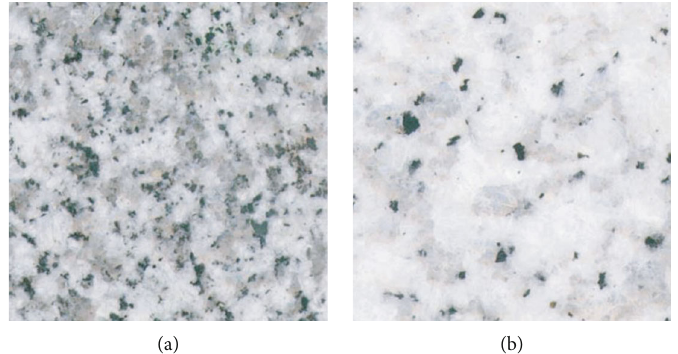
Figure 1: Comparison of granites with di ff erent fabrics with length and width of 30 mm [16].